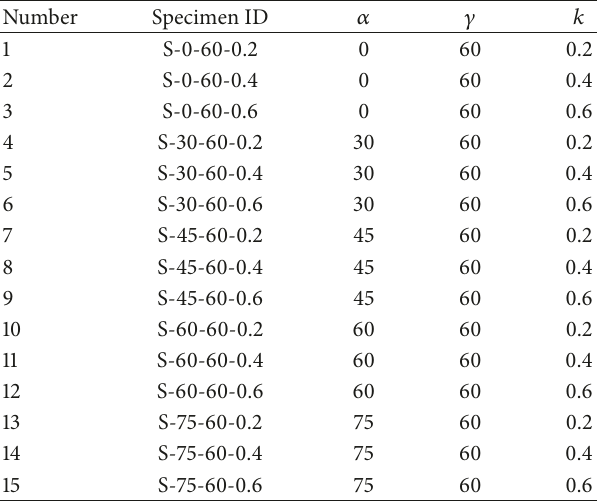
Table 2: Specimen numbers and fissure geometrical parameter values used for specimens with different 𝑘